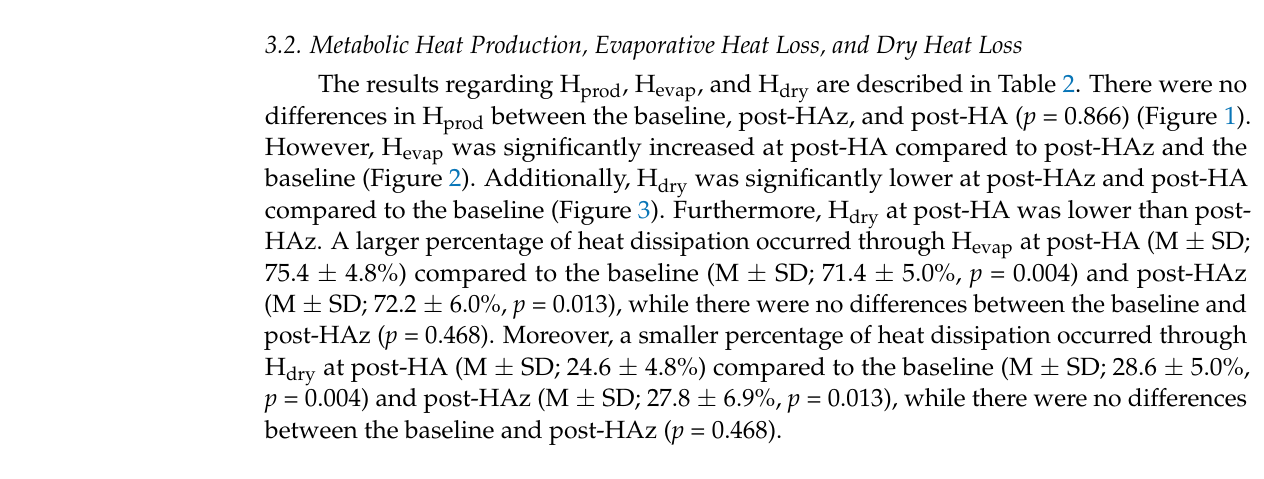
Table 2. Metabolic heat production, evaporative heat loss, dry heat loss, running economy, rate of maximal evaporative heat loss, and total evaporation required for heat balance of male endurance athletes. Baseline indicates unacclimatized, Post-HAz indicates post-heat acclimatization, Post-HA indicates post-heat acclimation (dual heat acc). Data are presented as mean (M) ± standard deviation (SD), effect size (ES), 95% confidence intervals (95%CI). * indicates statistical significance, p ≤ 0.05. Metabolic Heat Production (W · m − 2